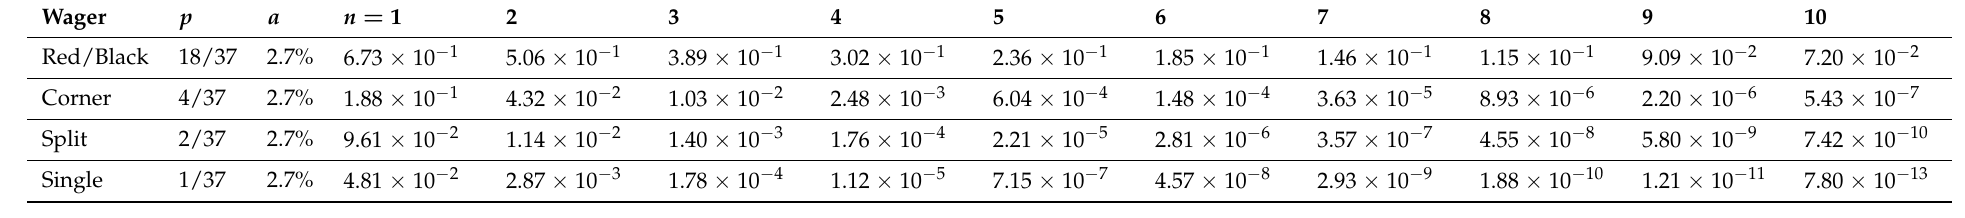
Table 4. The ROR probability obtained by applying the proposed model to each wager of roulette.